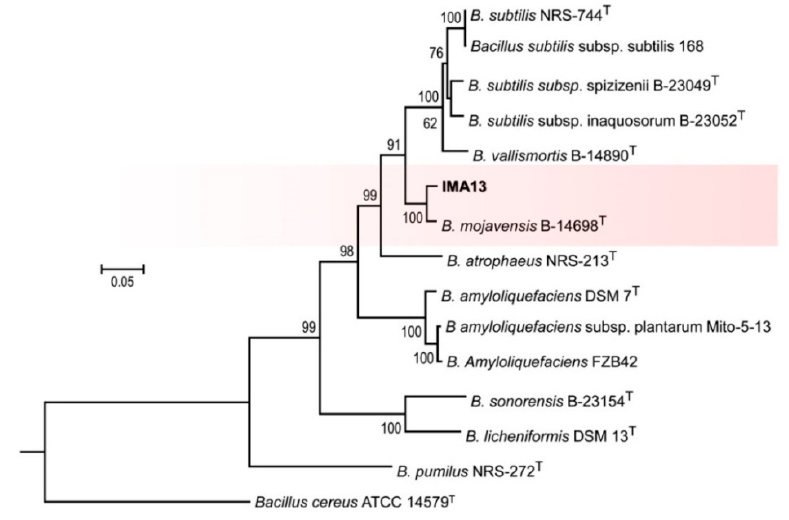
Figure 5. Maximum likelihood (ML) tree generated from a combination of gyrA, rpoB, purH, polC, and groEL gene sequences of 15 taxa. The tree is rooted with B. cereus . The type strains are indicated with T. Strains in this study are showed in bold.